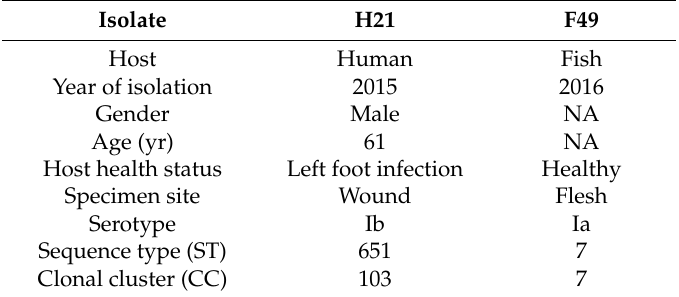
Table 1. Characteristics of Group B Streptococcus (GBS) isolates.